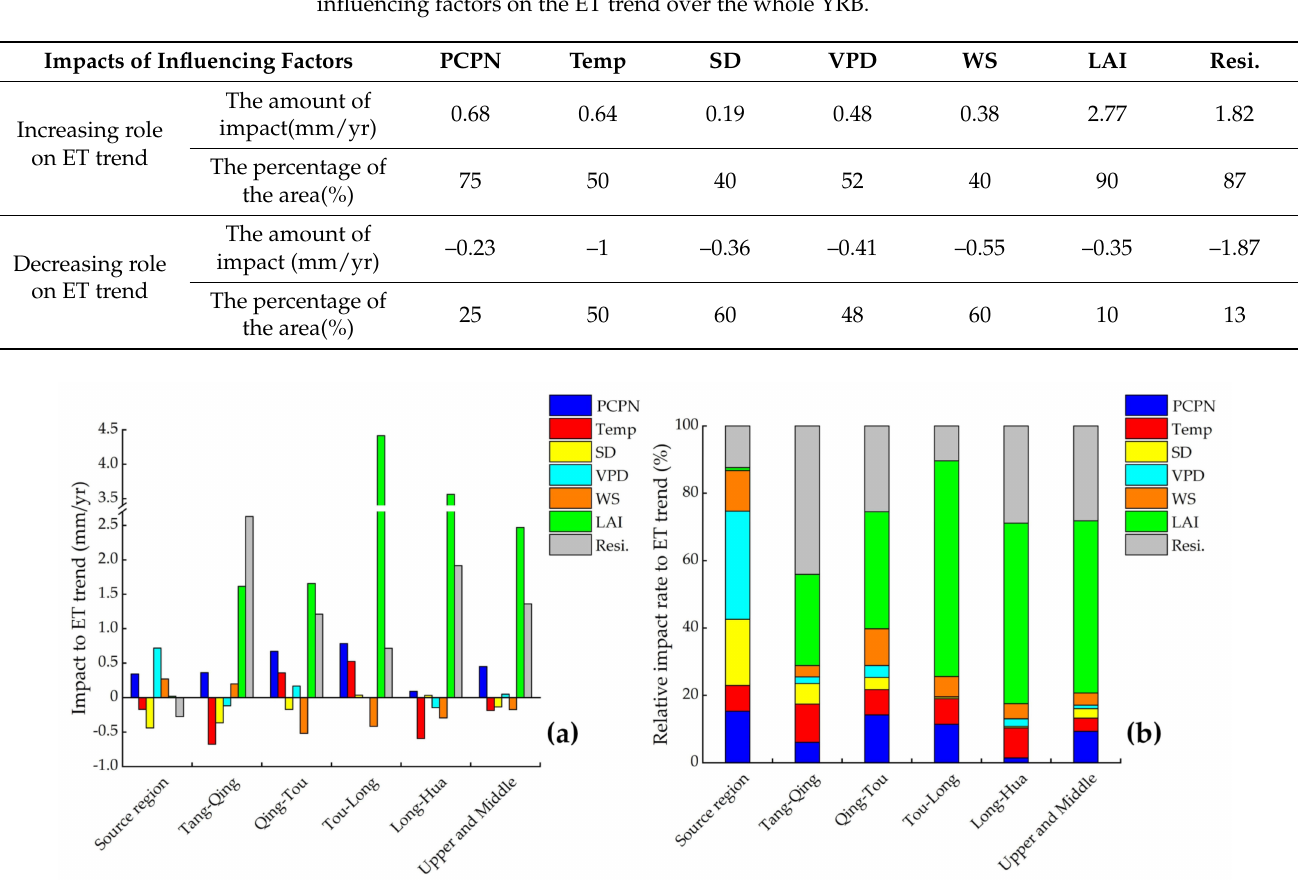
Figure 9. ( a ) Impacts and ( b ) relative impact rates of the different influencing factors on the ET trends in the different subregions in the